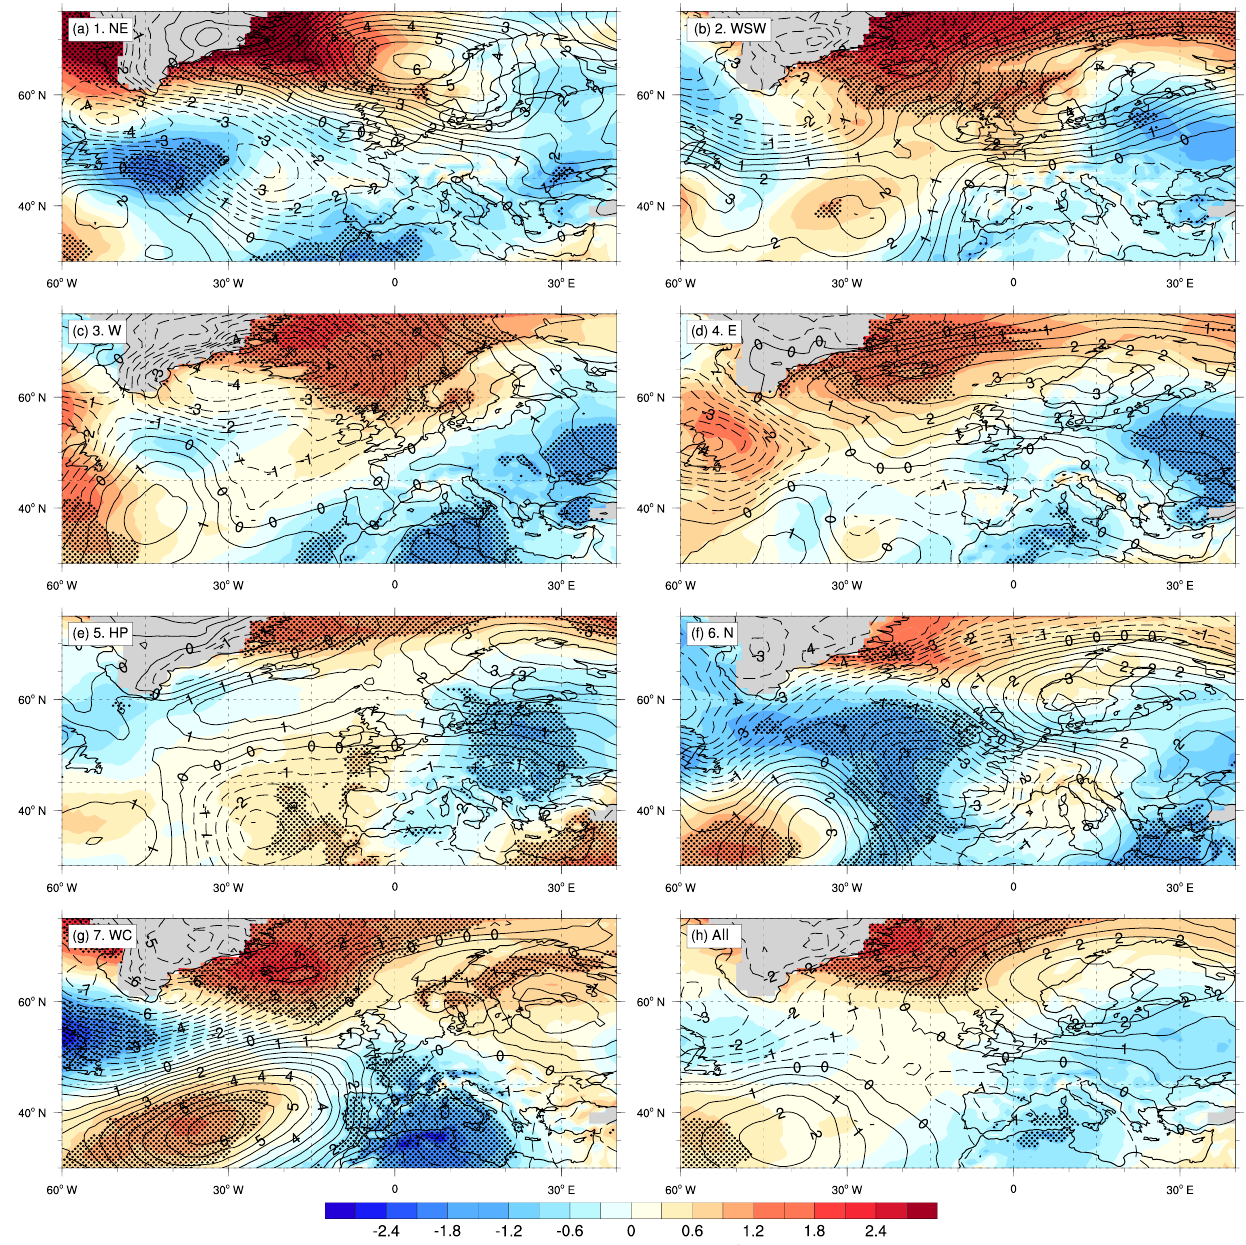
Figure 8. CAP7 (1 to 7) and mean (All) JFM sea level pressure (contour) in hPa and 850hPa temperature (colour) in ◦ C difference between low and high solar activity (low minus high) computed with ERA-40/Interim for the period 1958–2009. The 95% significance level is indicated by stippled